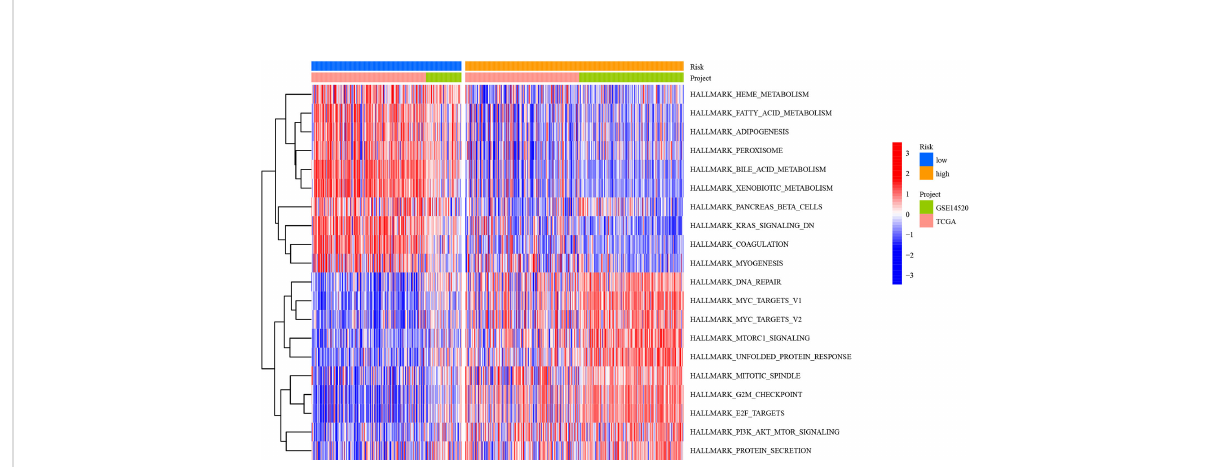
FIGURE 12 Heatmap showing GSVA scores of the hallmark gene sets for the fi ve de fi ned RNA processing